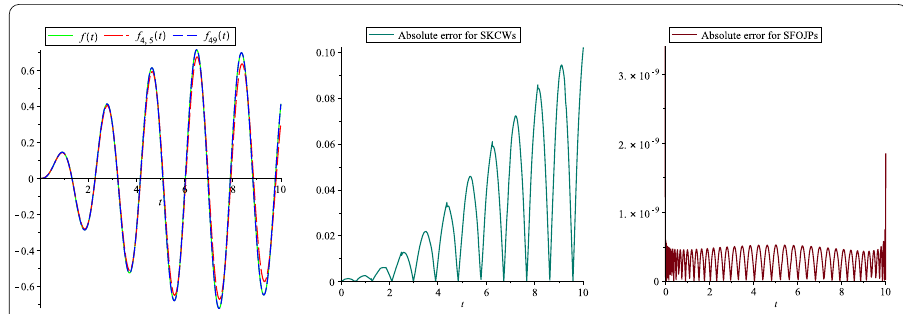
Figure 3 Graphs of the obtained results at the interval [0,10) by the SKCWs and SFOJPs methods with k = 4, M = 5, N = 49, λ = 1 , θ = ϑ = 0, for Example 6.3 2